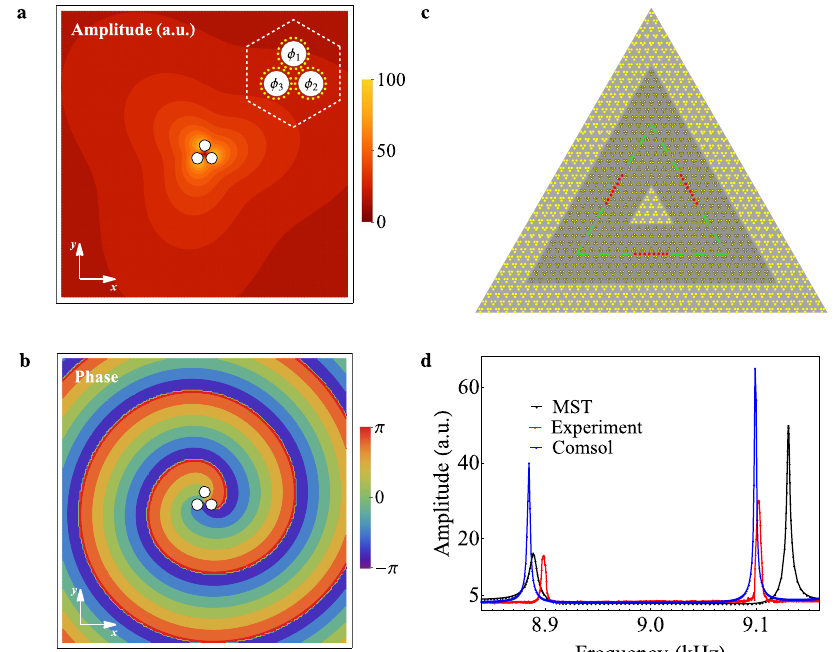
Fig. 2 Chiral whispering-gallery modes. a , b Characterising the near- and far- fi eld emission features of isolated trimers by means of uniformly distributed point sources surrounding each rod using the MST (see inset). In here, the emission phases are set to ϕ 1 = 0, ϕ 2 = 2 π /3 and ϕ 3 = − 2 π /3, resulting in a full gain cycle of ϕ = 2 π . The anisotropic pressure fi eld is accompanied by a left-handed chiral phase pro fi le. c A triangular WG interface (green dashed line) is created that separates two sonic crystals of opposite topological phase. The shaded area marks the zone inside which the cylinders are coated by the activated CNT layers. The red dots indicate the equidistant points from where the average pressure amplitudes have been evaluated. d Chiral WG amplitude spectrum (of order m = 27), obtained from numerical and experimental 32 evaluations for a gain-phase texture ϕ = 2 π